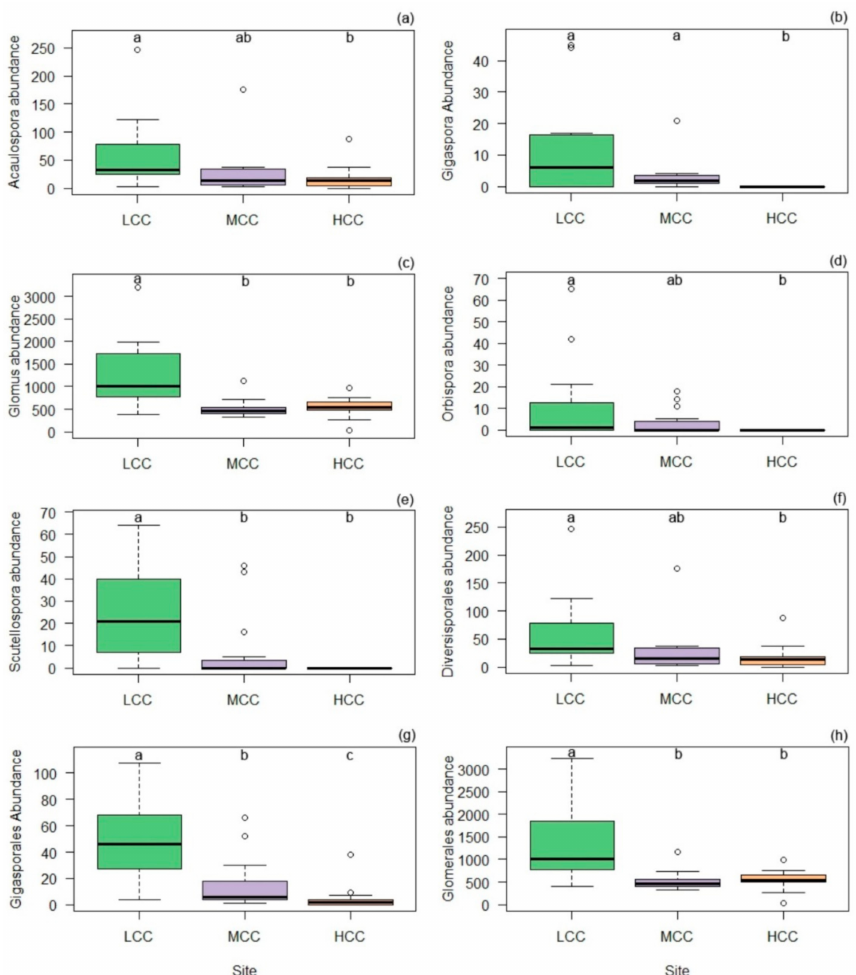
Figure 2. Abundance of genera ( a – e ) and orders ( f – h ) of AMF in soil in three areas with a clay gradient (LCC: Low Clay Content, MCC: Medium Clay Content, HCC: High Clay Content). ( a ) Acaulospora , ( b ) Gigaspora , ( c ) Glomus , ( d ) Orbispora , ( e ) Scutellospora , ( f ) Diversisporales, ( g ) Gigasporales, ( h ) Glomerales. Bars followed by the same letter do not di ff er